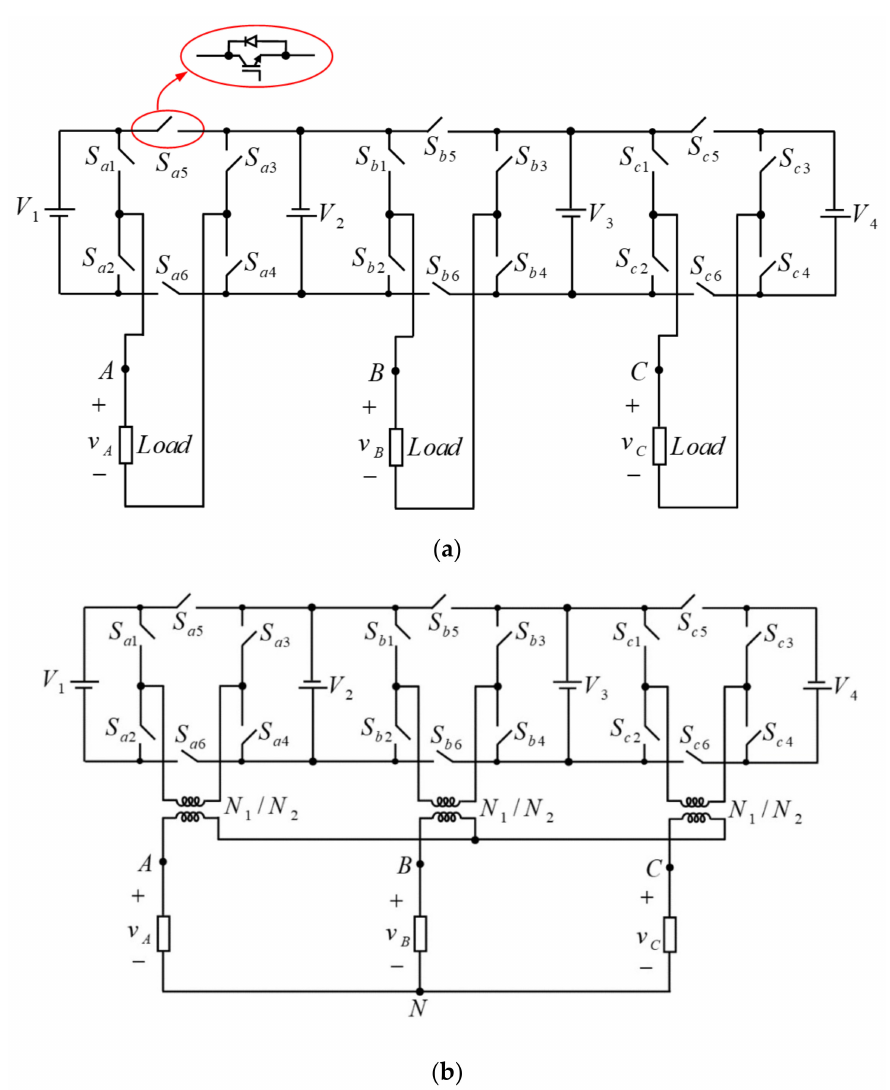
Figure 1. Proposed three-phase multilevel inverter; ( a ) Three independent loads; ( b ) Three-phase load connected in Y